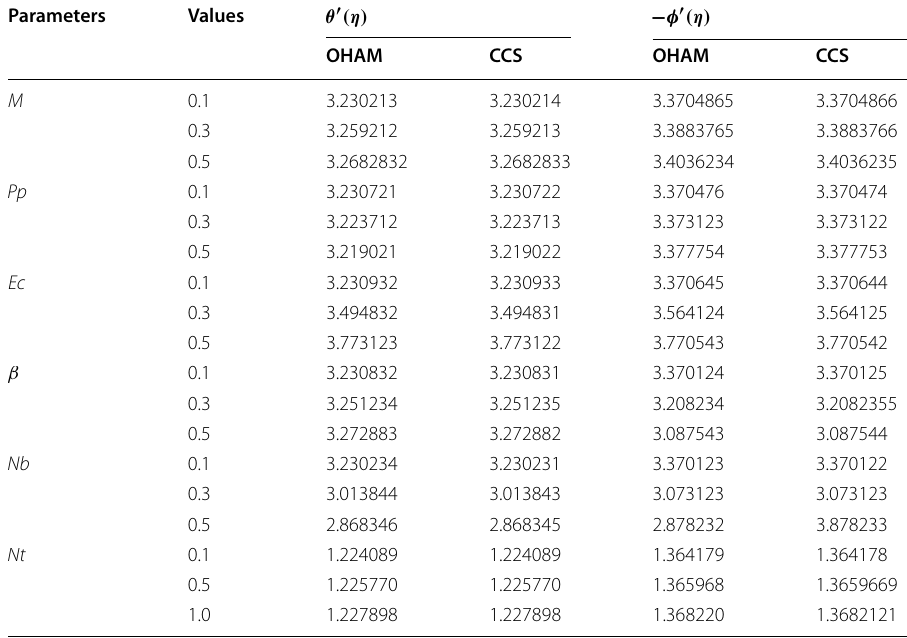
Table 5 Values of Nusselt number and Sherwood number for various parameters Parameters